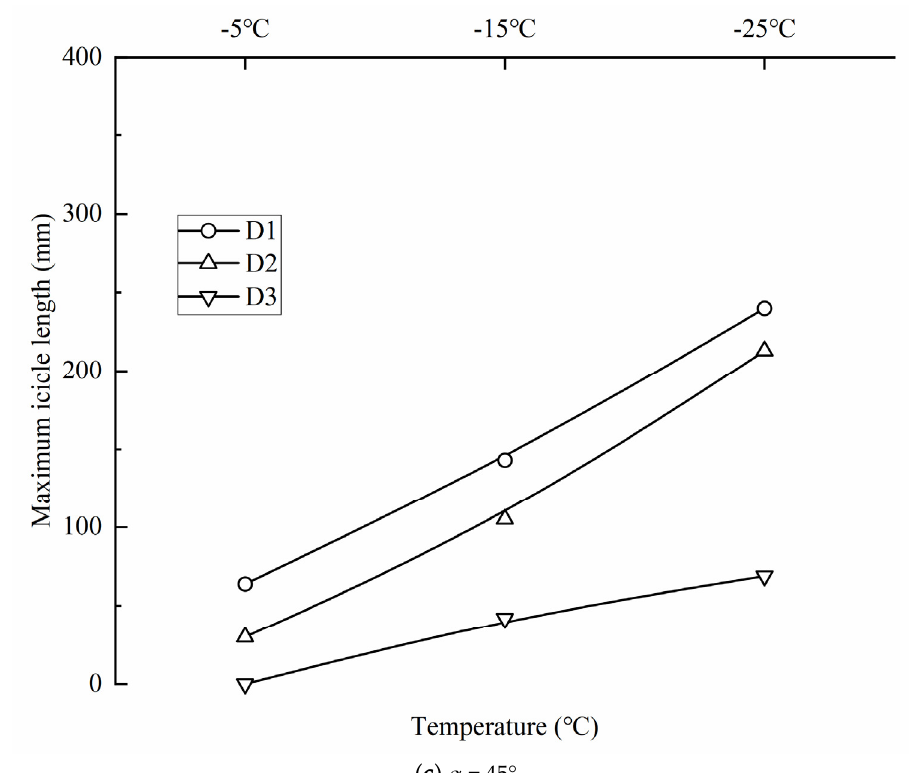
Figure 7. ( a – c ) Influence of ambient temperature on maximal length of icicles.